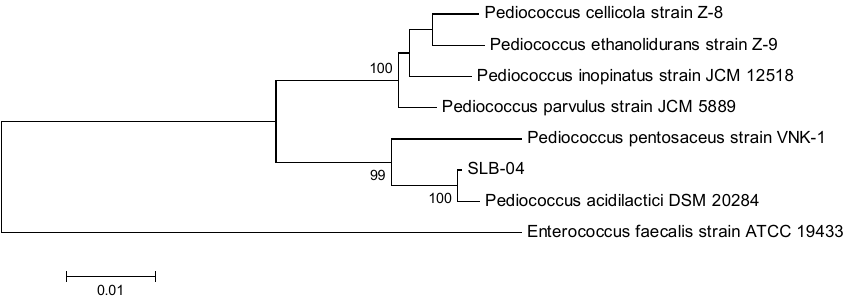
Figure 1. The 16S rDNA phylogenetic tree constructed on the basis of the adjacency method. Based on the results of the morphological, physiological, and biochemical tests, as well as the 16S rDNA sequence analysis, SLB-04 was preliminarily identified as Pediococcus acidilactici . The strain was stored at the China Microbiological Culture Preservation Center (CGMCC), no.